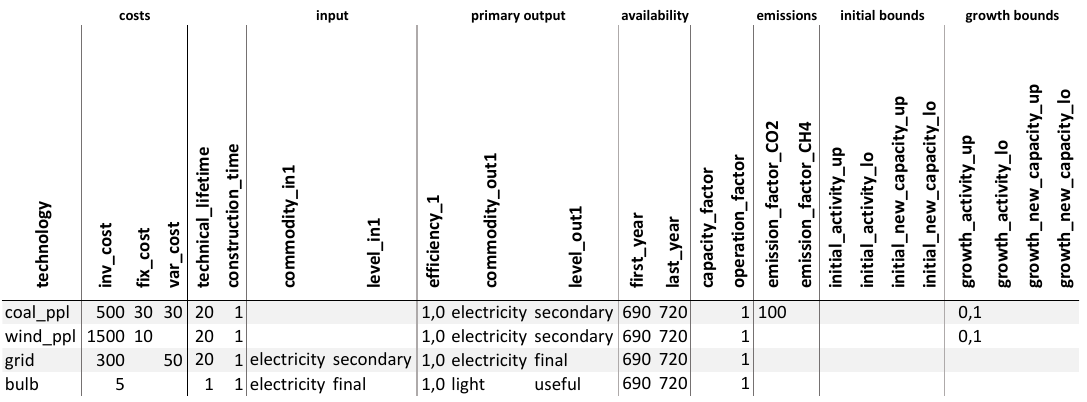
Figure 3. Reduced spreadsheet input for technology specification for the